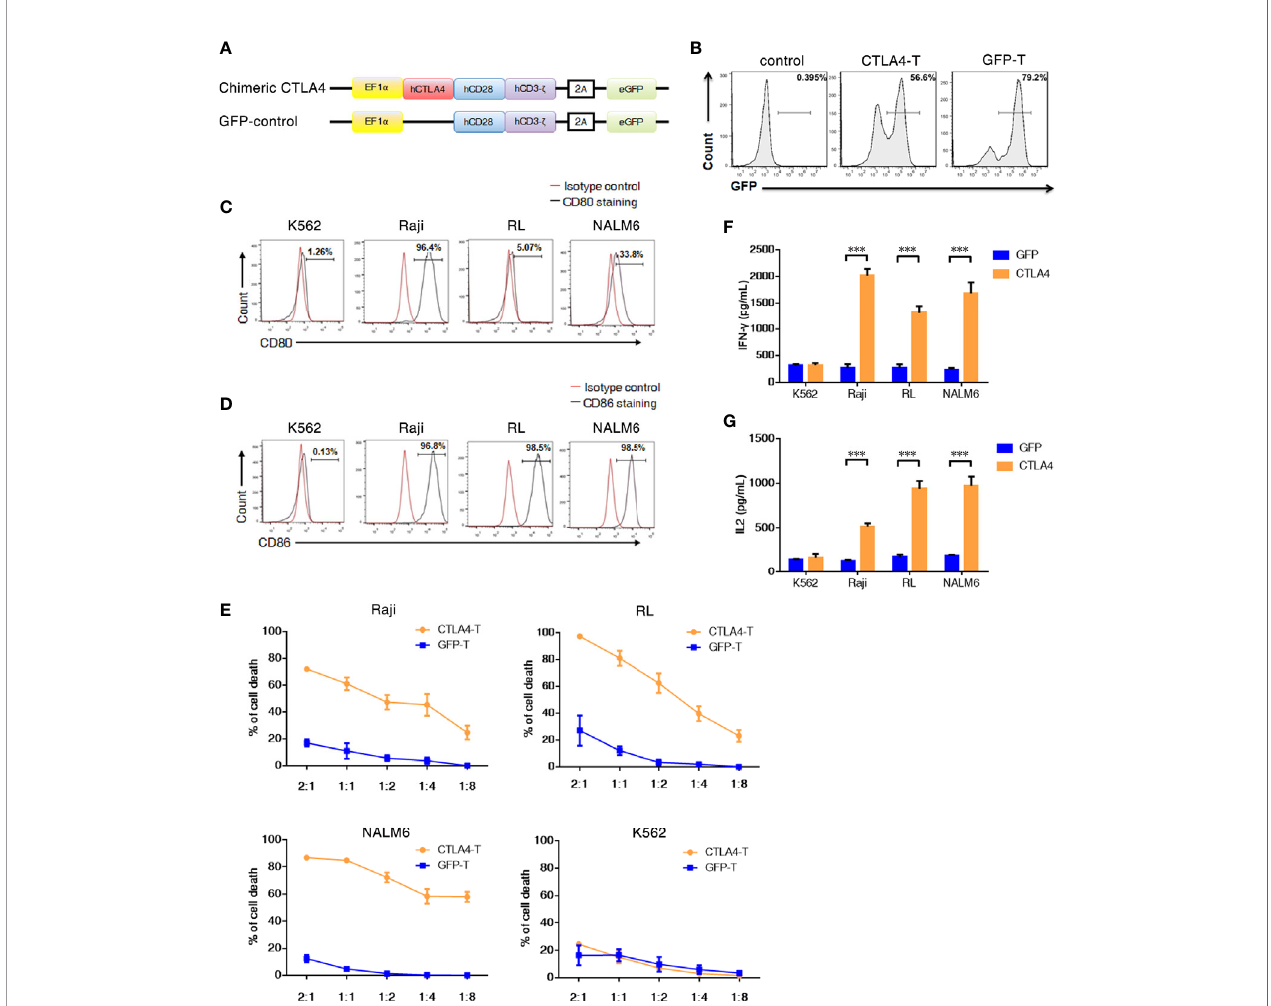
FIGURE 1 | T cells transduced with the CTLA4-CD28-CD3z chimeric gene showed enhanced in Vitro Cytotoxicity. (A) The chimeric CTLA4 molecule contains the extracellular and transmembrane domains of human CTLA4, the cytoplasmic signaling region of human CD28, and the intracellular domain of human CD3z. GFP was used to fl uorescently label the cells. (B) Representative fl ow cytometric analysis of the transduction ef fi ciency of chimeric CTLA4 or GFP (control) in human activated T cells that were transduced with a lentivirus. CTLA4-T: CTLA4 chimera-transduced T cells, GFP-T: GFP-transduced T cells. (C, D) Representative fl ow cytometric analyses of CD80/CD86 expression in K562, Raji, RL, and NALM6 cells. (E) Activated T cells transduced with either chimeric CTLA4 or GFP (control) and cocultured with the indicated cell lines for 18 h, mean ± SD. The levels of IFN- g (F) and IL-2 (G) secreted into the culture supernatant were measured by ELISA with a 1:1 E:T ratio, mean ± SD, unpaired two-tailed t-test. Signi fi cance values: ***P <